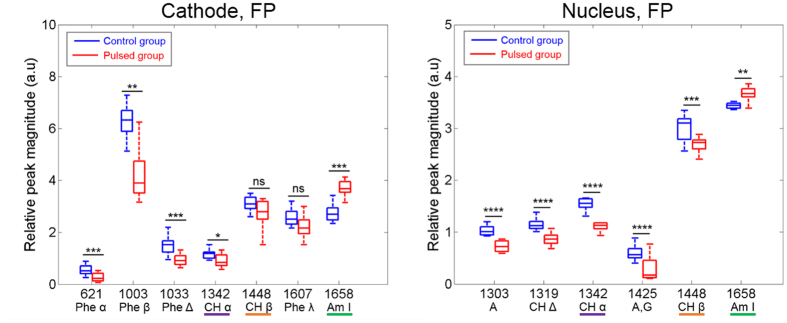
Relative peak magnitude of the discriminant peaks identified of “Cathode, FP” and “Nucleus, FP” conditions.The common bands in the two conditions are underlined with specific color. The p-values between the two groups are displayed. The pulse conditions are 8 pulses, 100 μs, 1 000 V/cm and 1 Hz. Student’s t-test: ns (non-statically significant): p-value > 5%, p-value ≤ 5%, **p-value ≤ 1%, ***p-value ≤ 0.1%, ****p-value ≤ 0.01%.